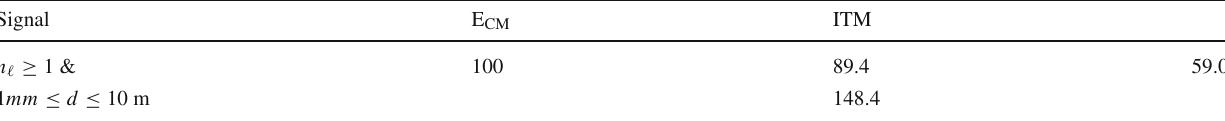
Table 5 n (cid:12) ≥ 1 + (cid:12) p T < 20GeV signature with displacement 1 mm ≤ d ≤ 10 at centre of Mass energy of 100 TeV for the chosen BP of ITM at an integrated luminosity of 1000 fb −